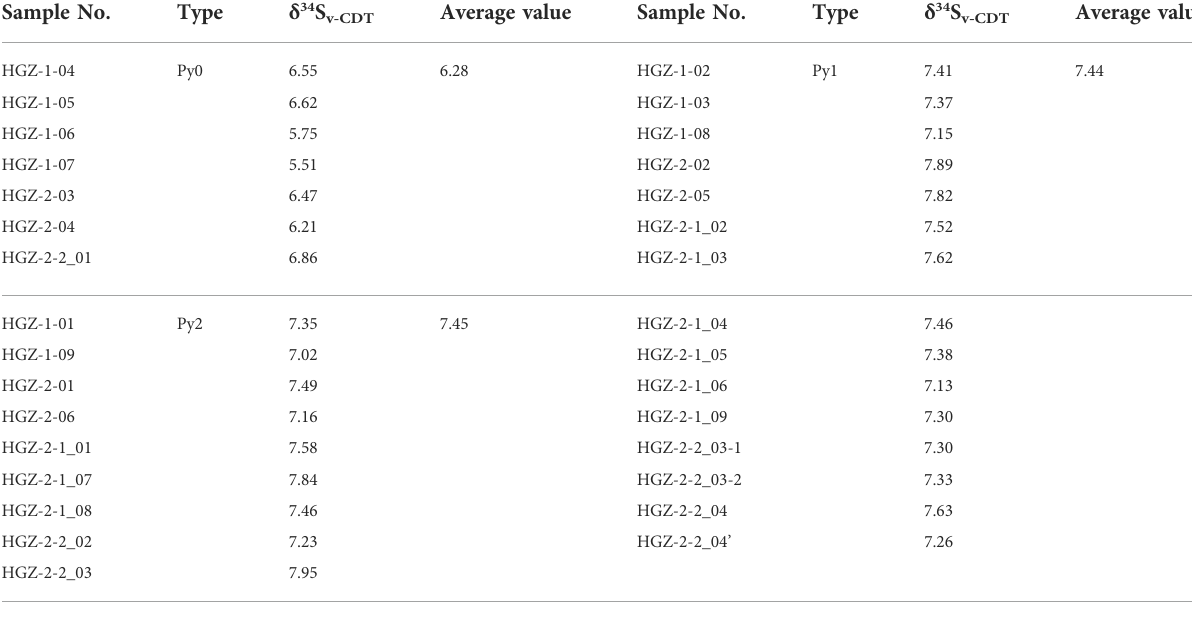
TABLE 3 Results of the in situ analysis of sulfur isotopes of pyrite in the Houge ’ zhuang gold deposit. Sample No.